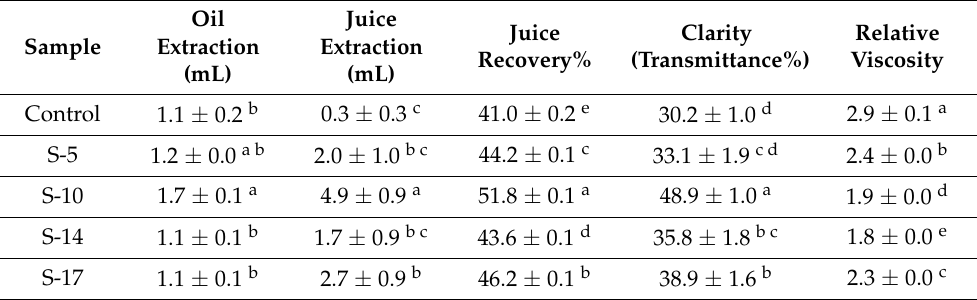
Table 2. Application of pectinase produced from those isolates in oil and juice